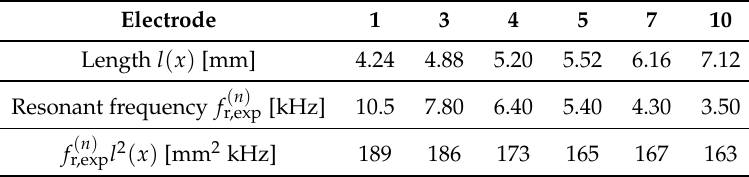
Figure 5. Local oscillation amplitude Z of each electrode measured via the inverse piezoelectric effect plotted against the input frequency of the local electrical stimulus f local,elec . Large peaks are present for electrodes 3, 5, and 10, and the location of these peaks can be identifies as the local resonance ( n ) = 3,5,10). However, it is difficult to determine the resonance frequencies for frequencies f r,exp ( n electrodes 1, 4, and 7, because they show no clear peaks as a result of their oscillation in response to neighboring resonance frequencies. Therefore, these resonance frequencies are determined by theoretical prediction. It is revealed that the present device has the frequency selectivity as the analog fast Fourier transform (FFT) device mimicking the biological basilar membrane in the cochlea due to the trapezoidal configuration, which is the key functions for fully implantable cochlear implants. Table 2. Resonance frequencies for each electrode. Based on the linear beam vibration theory, the trapezoidal membrane was modeled as a set of beams extended in y -direction, as shown in Figure